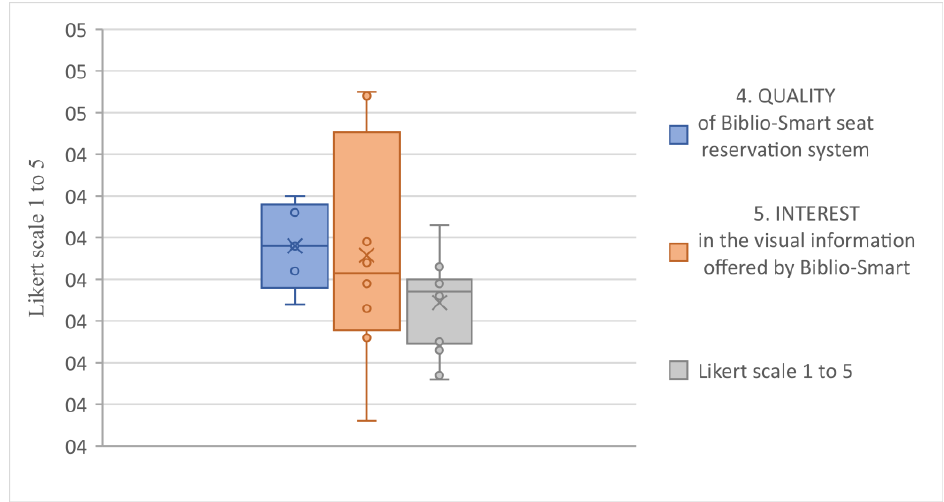
Figure 16. Comparative box plots of data of interest on the three main dimensions analyzed (minimum, first quartile, median, third quartile, maximum, etc). mum, first quartile, median, third quartile, maximum, etc).